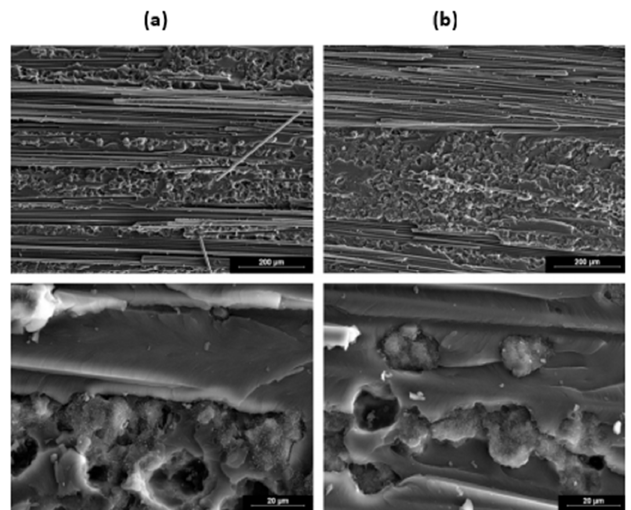
Figure 19. Fracture surface ( a ) for 10 Hz ( b ) for 100 Hz [52].